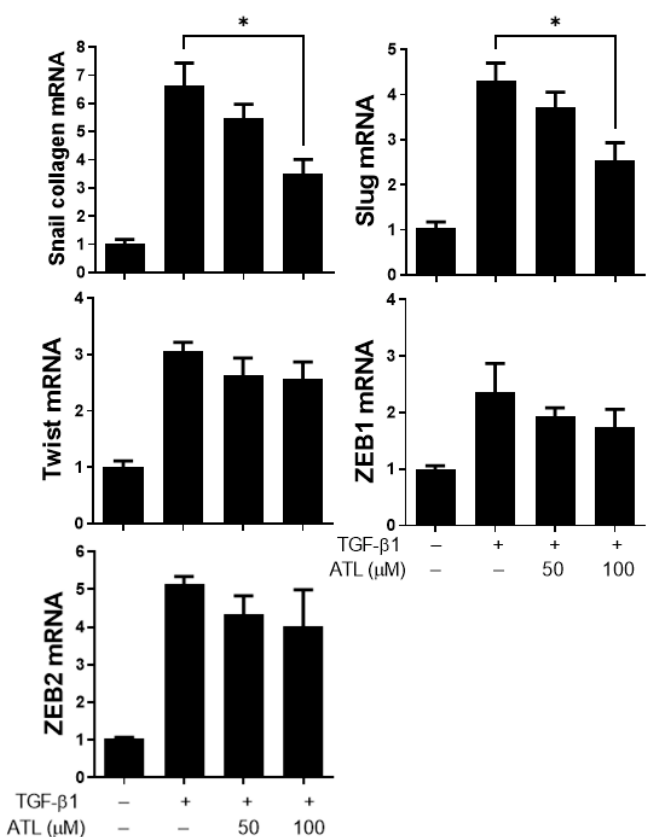
Figure 3. Atractylodin moderately reduced EMT-related transcription factor expression in TGF- β 1- treated A549 cells. A549 cells were pretreated with ATL for 1 h followed by TGF- β 1 (2 ng/mL) stimulation for an additional 24 h. Cells treated with DMSO were set up as the control group. Real-time PCR was exploited for quantifying the expressional changes of EMT-related transcription factors, including Snail, Slug, Twist, ZEB1, and ZEB2. Values represent the mean ± SEM from triplicate samples for each treatment. (*) p < 0.05 versus TGF- β 1 + 0.1% DMSO-treated control, as determined by